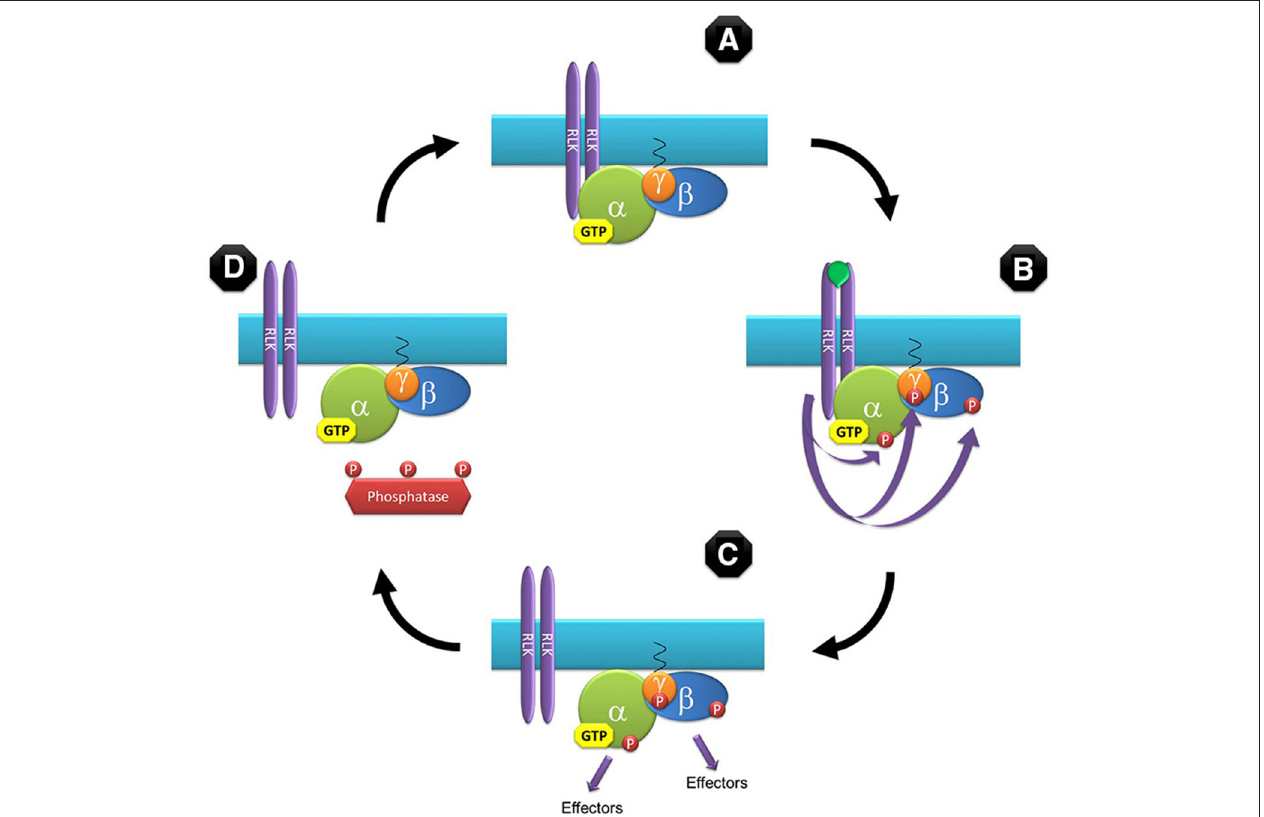
FIGURE 1 | Model for the G-protein cycle in plants. This model assumes that G α is bound to GTP by default based on the reported kinetic properties for GPA1. The GTP-bound heterotrimer has the proper conformation to allow interaction with downstream effectors but is not functionally active (A) . Upon binding of an agonist, RLKs (or other associated kinases) phosphorylate the G-protein subunits, activating them and initiating the signaling cycle (B) . Signaling proceeds by the two functional subunits (G α and the G βγ dimer) (C) until the phosphate groups are removed by phosphatases (D) rendering the heterotrimer inactive and associating again with a RLK to complete the cycle (A) . In this model G α can be either the canonical (GPA1-like) or non-canonical (XLG-like) subunit.